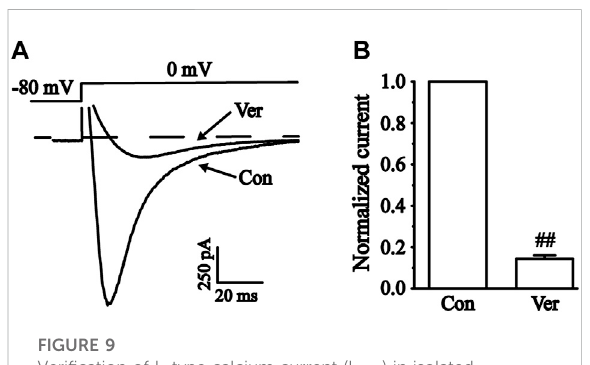
FIGURE 9 Veri fi cation of L-type calcium current (I Ca-L ) in isolated cardiomyocytes. (A) Representative traces of I Ca-L with a steady- state activation before and after using 10 μ M Ver. (B) Pooled data were expressed as the mean ± SEM. Each group has 10 cells from fi ve to six rat hearts. ## p < 0.01 vs. Con